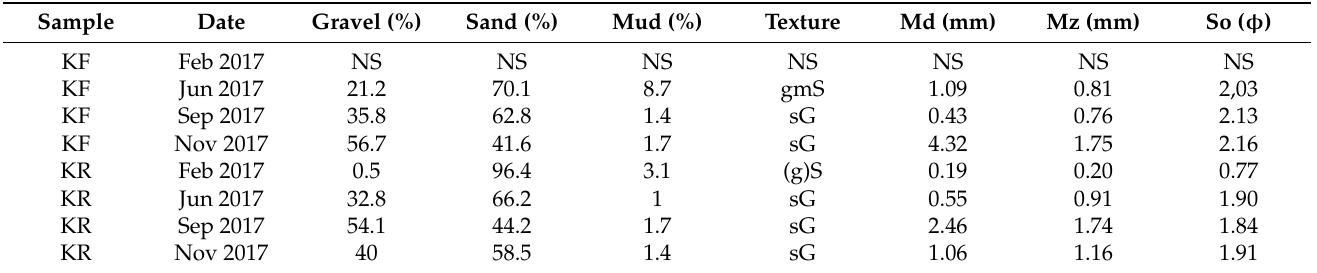
Table 2. Summarized grain size data for Krka fish farm (KF) and Krka River reference site